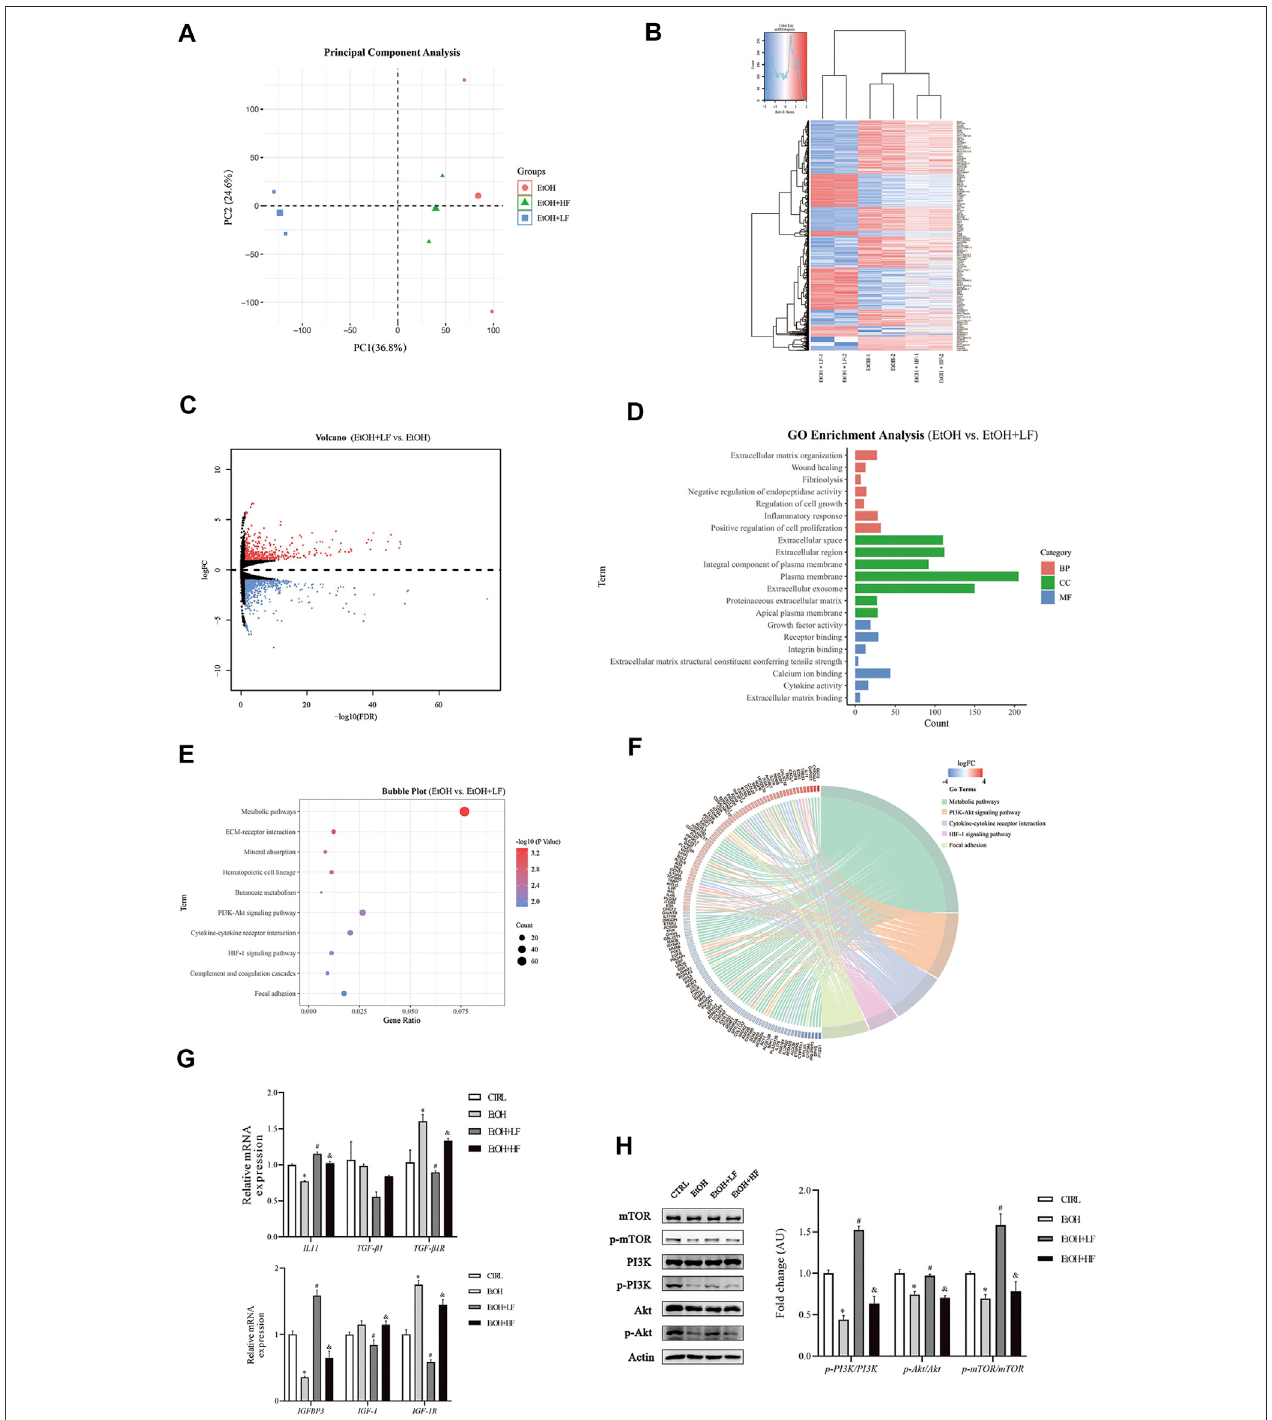
FIGURE 3 | mRNA changes after furfural treatment of HepG2 cells. (A) Principal component analysis (PCA) score plot for three treated groups. (B) Heatmap showing the mRNA expression pro fi les between groups. Red stripes represent highly expressed genes, while blue stripes represent genes expressed at low levels. (C) Volcano map of DEGs between the EtOH group and EtOH + LF group. Red dots represent highly expressed genes in the EtOH + LF group, while blue dots represent genes expressed at low levels. (D) GO enrichment histogram between the EtOH group and the EtOH + LF group. (E,F) The KEGG pathway enrichment analysis betweentheEtOH groupand EtOH +LFgroup. Chorddiagramshowingtheannotated genesand theirexpression inenriched pathways.Redbars represent high gene expression in the EtOH + LF group, while blue bars represent low gene expression. (G) The mRNA levels of fi brosis-related factors as measured by RT-qPCR. (H)